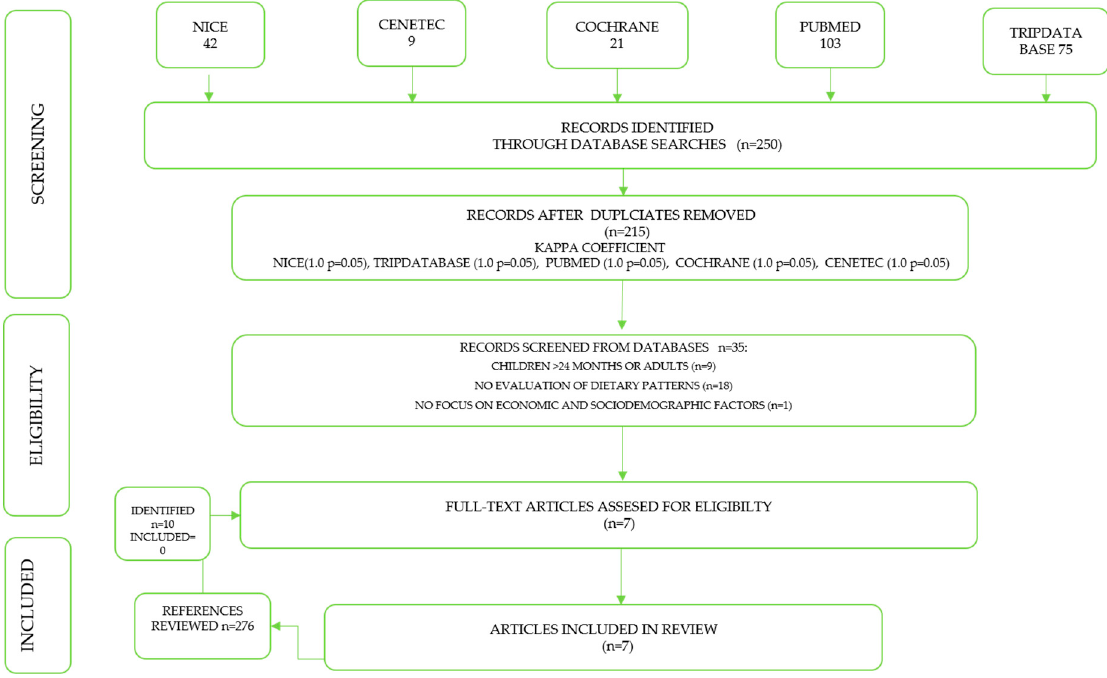
Figure 1. Literature review and selection criteria flow chart.